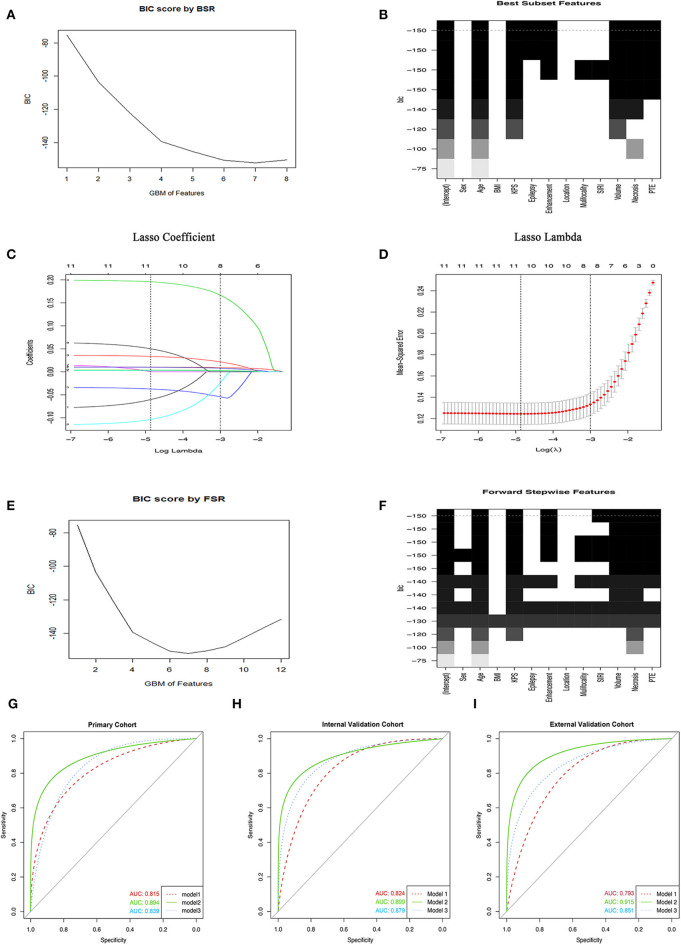
Variables selection methods. (A,B) The selection of variables using the BSR method. (C) The LASSO coefficient profile of 12 GBM-related variables in primary cohort. (D) 10-fold cross-validation (CV) for tuning parameter (λ) selection. (E,F) The FSR method was used to select variables. (G–I) The ROC curves of GBM in primary cohort and two validation cohorts, respectively. BIC, Bayesian information criterion; GBM, glioblastoma multiforme; BSR, best subsets regression; FSR, forward stepwise regression; BMI, body mass index; SIRI, systemic inflammation response index; pEO, preoperative epilepsy occurrence; pKPS, preoperative Karnofsky performance status; PTE, peritumoral edema.